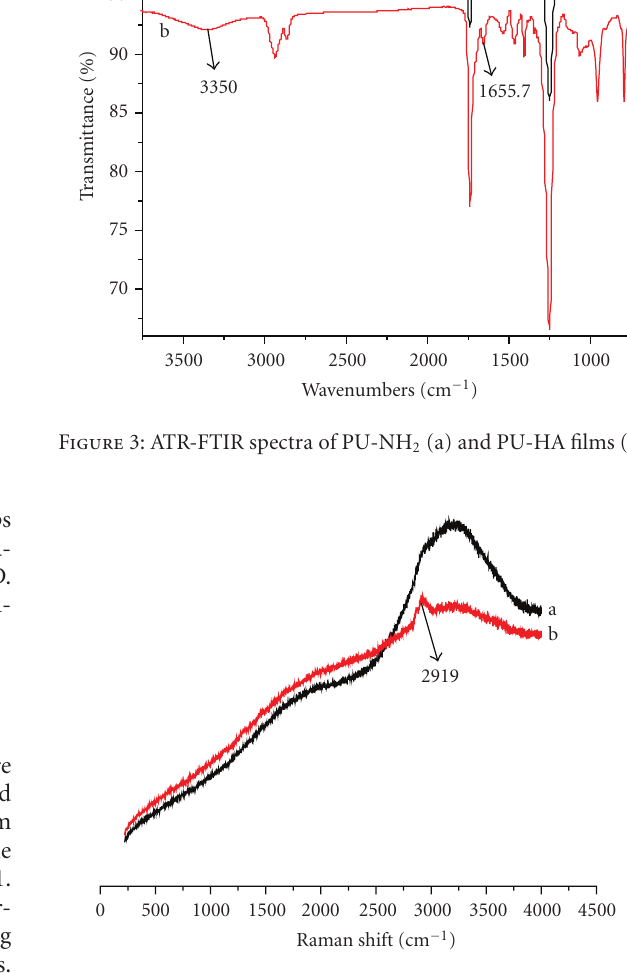
Figure 4: Raman spectra of PU-NH 2 (a) and PU-HA